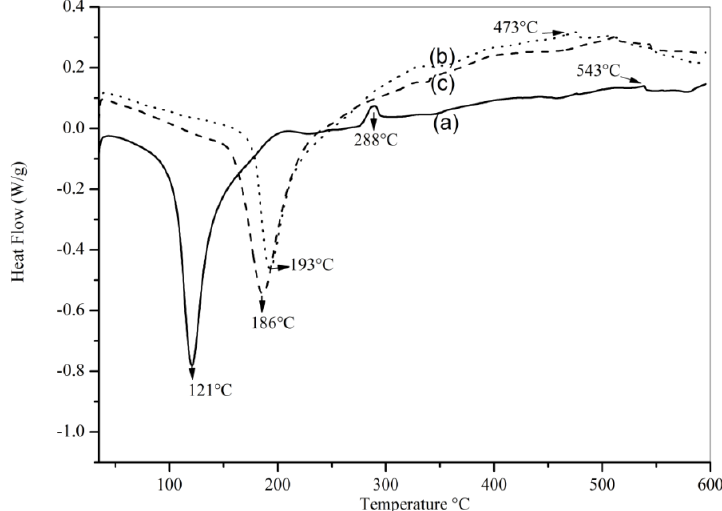
Figure 5. DSC profiles: ( a ) KMnO and ( c ) MnAlT400W.